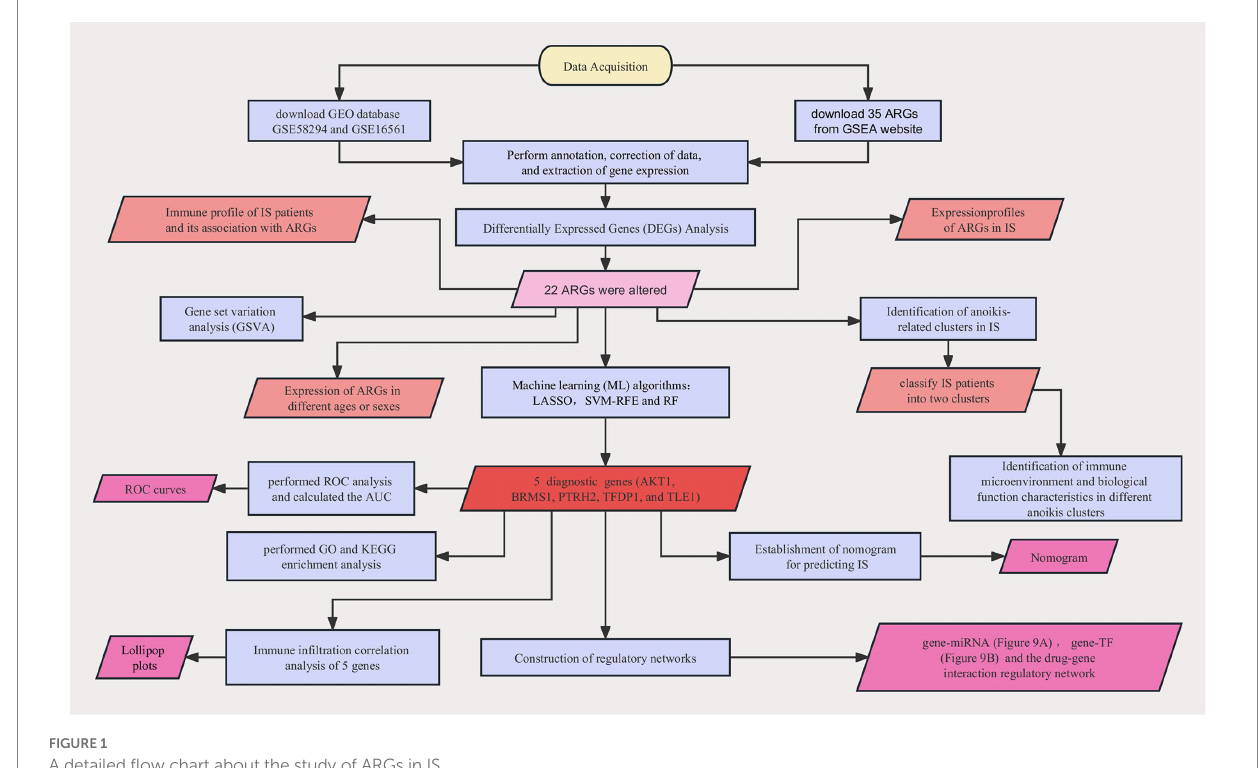
FIGURE 1 A detailed flow chart about the study of ARGs in